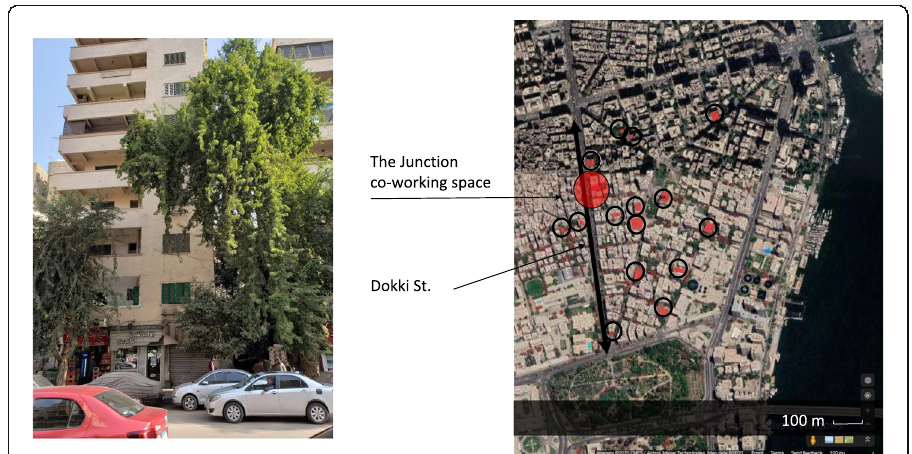
Fig. 6 The residential building (on the left) that accommodates “ The Junction co-working space ” ; one of the co-working spaces in Dokki area (on the right): the junction co-working space. Map source https://www. google.com/maps , elaboration and picture captured by